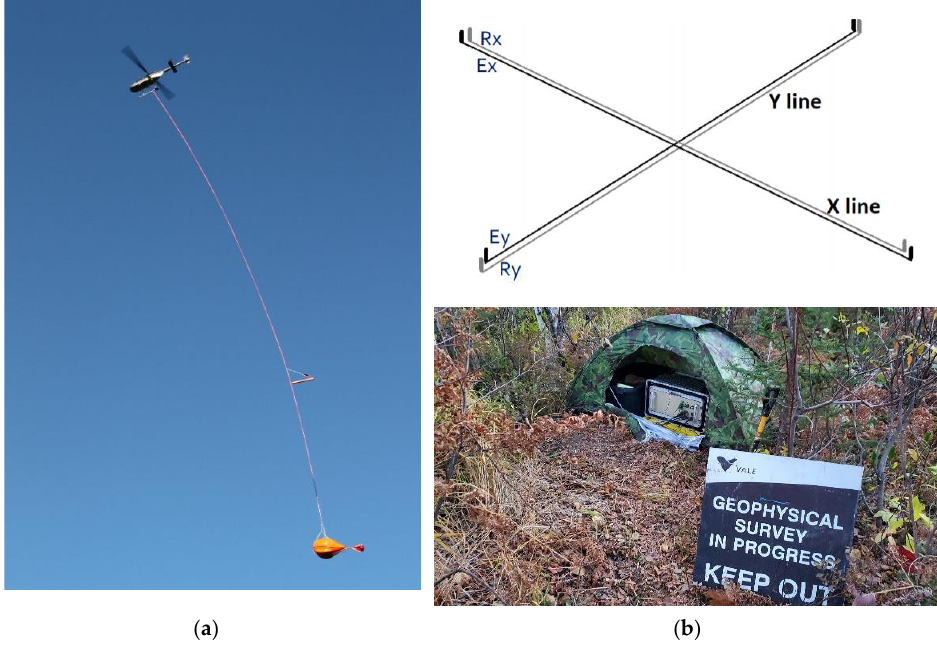
Figure 2. MobileMT system: ( a ) H-field airborne bird with three orthogonal induction coils located inside a fiberglass shell, towed by a helicopter; ( b ) E-field base station consists of four independent grounded electrical lines measuring the horizontal components of the electrical field and the data acquisition system.